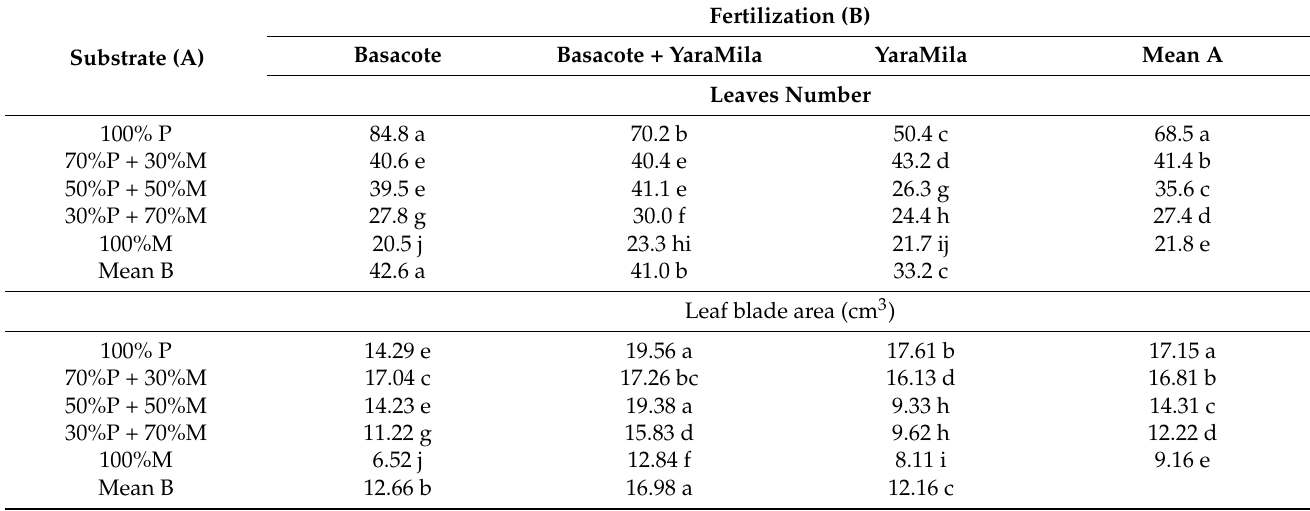
Table 4. Selected leaf features of Sedum spectabile ‘Stardust’ grown in containers with five different substrates.